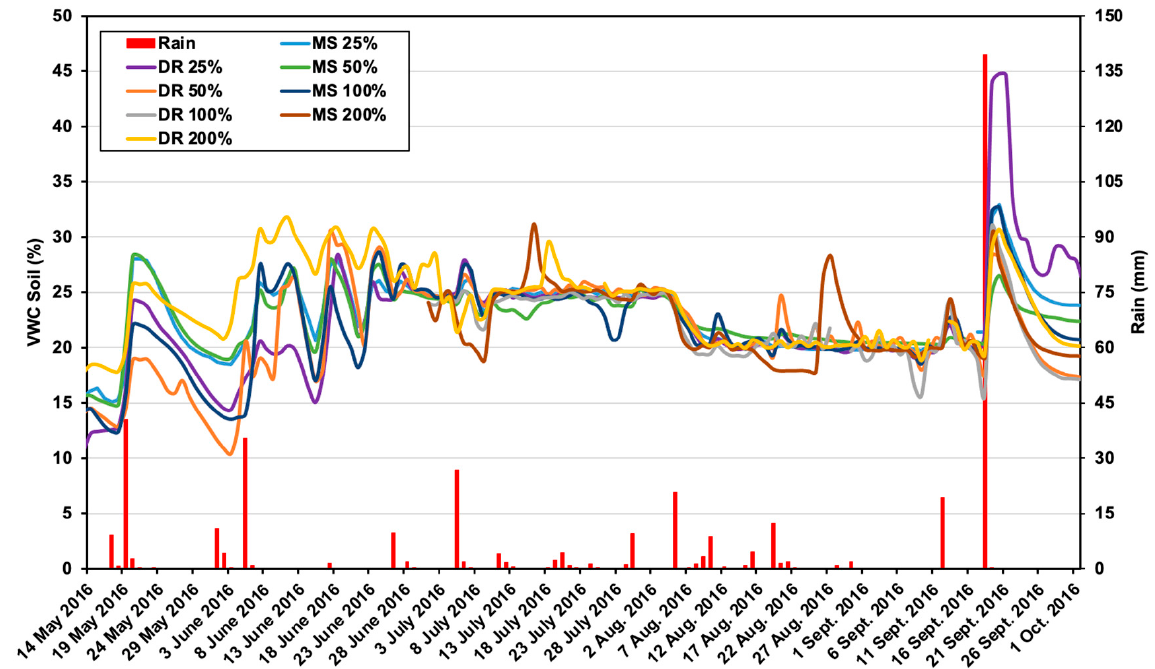
Figure 1. Soil volumetric water content (VWC) for the different combinations of drip (DR) and micro-sprinkler (MS) irrigation with different fertilizer levels (25, 50, 100, and 200%) in 2016. Rain events are shown as vertical bars. From 14 May 2016 to 22 June 2016, the irrigation system was being tested and the irrigation was controlled by hand, trying to keep the VWC above 25%. After 23 June 2016, the automated irrigation network was turned on, following the thresholds established (from early May to early August: VWC threshold of 25%; from early August to mid-September: VWC threshold of 20%; from mid-September to late September: VWC threshold of 15%; late September to December: irrigation off). Values are the average of four sensors (two at 20 cm and two at 40 cm depth).